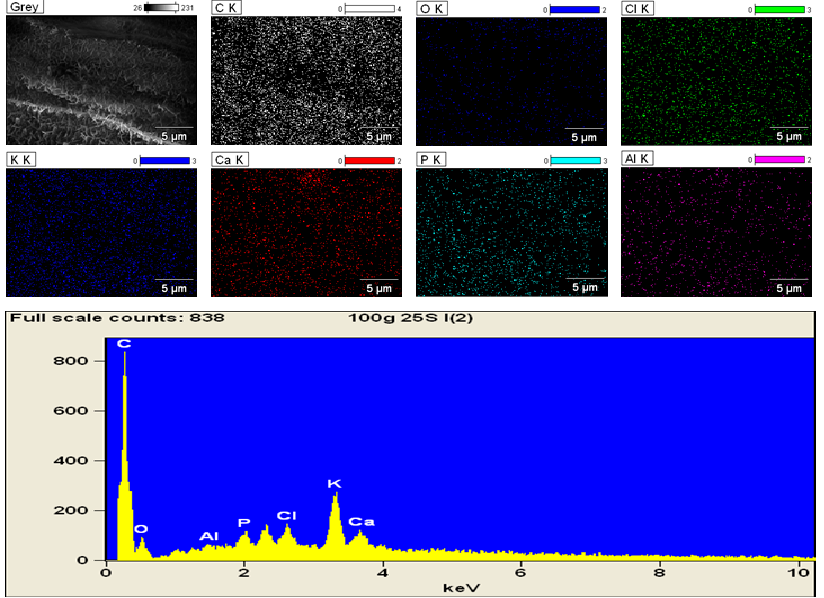
Figure 3. SEM analysis of shoots for 100 g 25S nZVI/kg of soil.